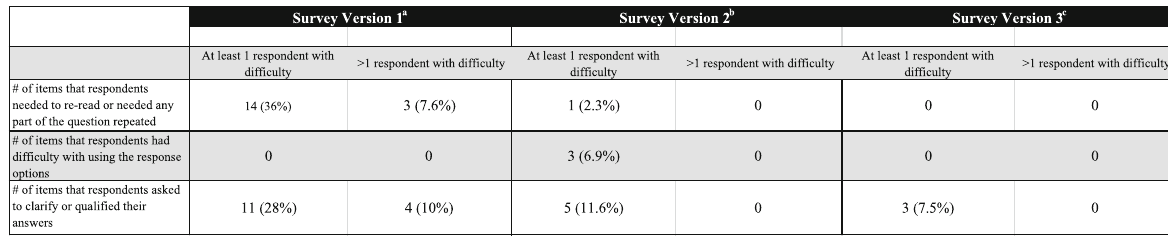
Key-- This table indicates the number of items that respondents had difficulty with in each version of the instrument, and what type of difficulty. Columns are split by items in which only one respondent had difficulty vs items where more than one respondent had